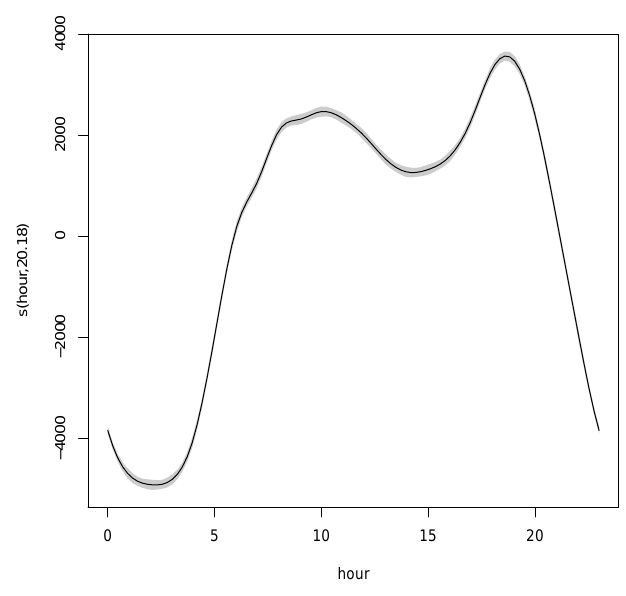
Figure 3. Smoothed effects of variable “hour”.